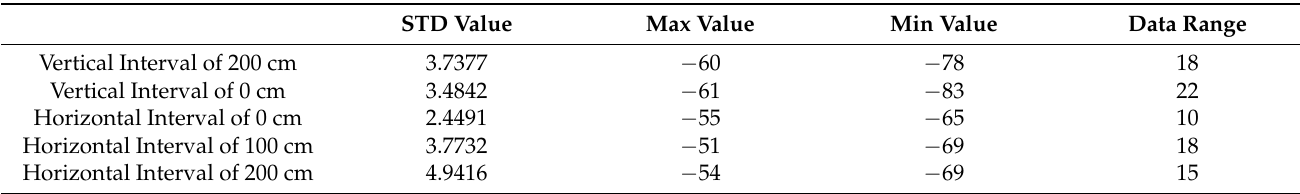
Table 1. Numerical analysis of various settings of Bluetooth